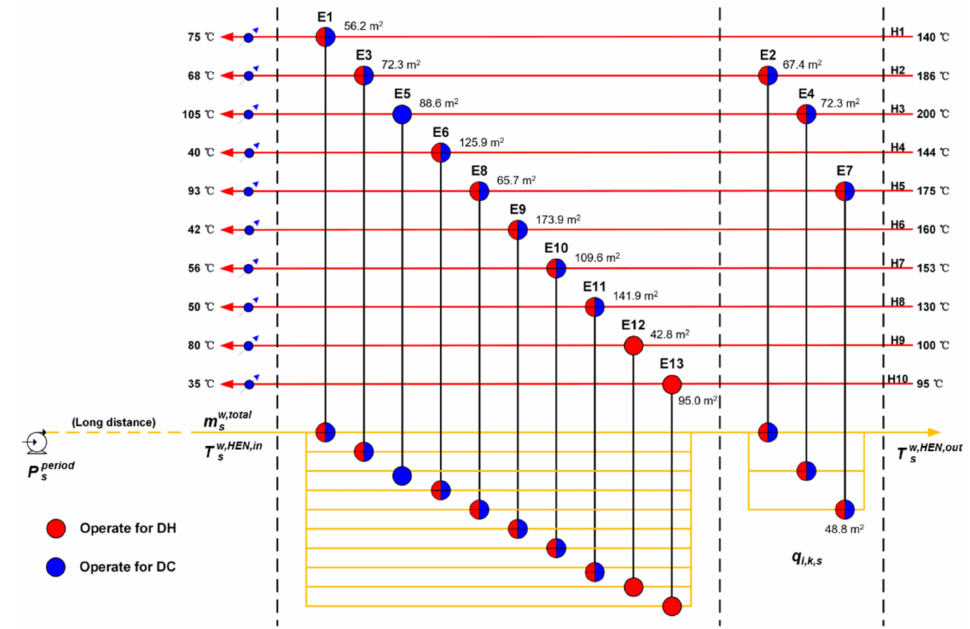
Figure 4. The heat exchanger network (HEN) of the first